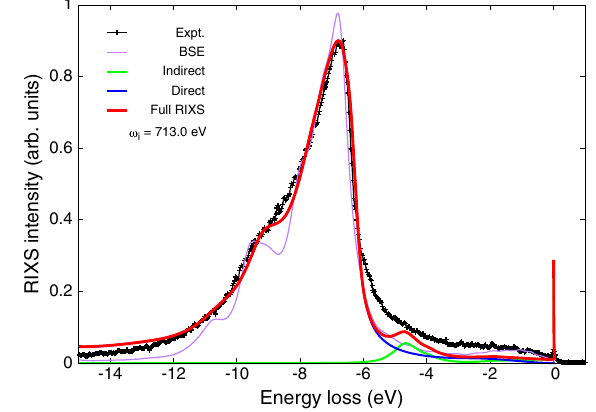
FIG. 9. Measured and calculated full RIXS profile for BaFe 2 As 2 for an incident photon energy of 713.0 eV. Direct (blue curve) and indirect (green curve) contributions, calculated by Eqs. (13) and (14), respectively, are shown in addition to the full RIXS signal (red curve) with comparison to the BSE result for the full Kramers-Heisenberg equation (violet curve) and experimental result (black curve). Calculations use a core-hole lifetime of 0.2 eV HWHM and a Doniach-Sunjic spectral function with 0.16 eV linewidth and 0.14 asymmetry